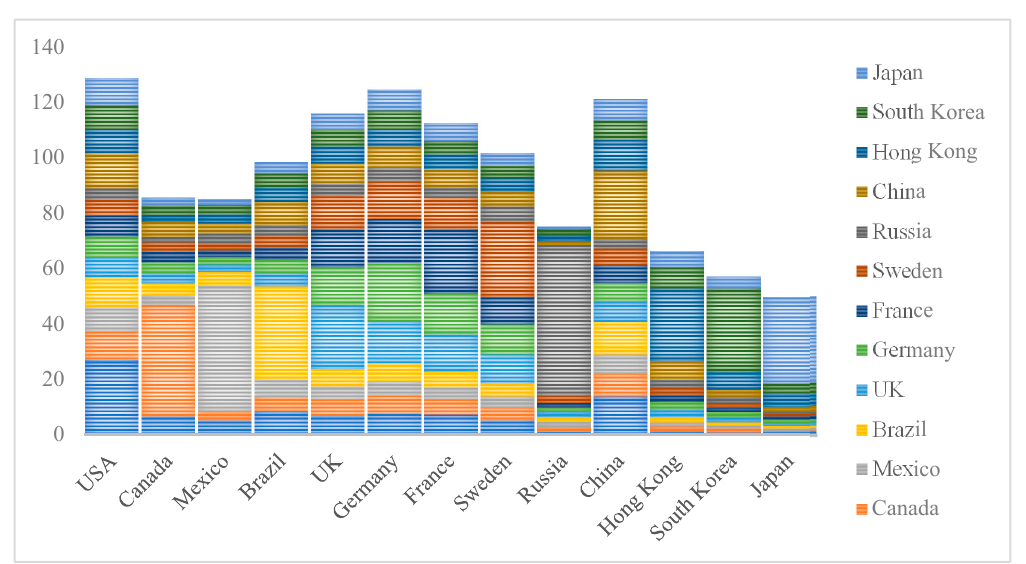
Figure 2. Short-term connectedness.